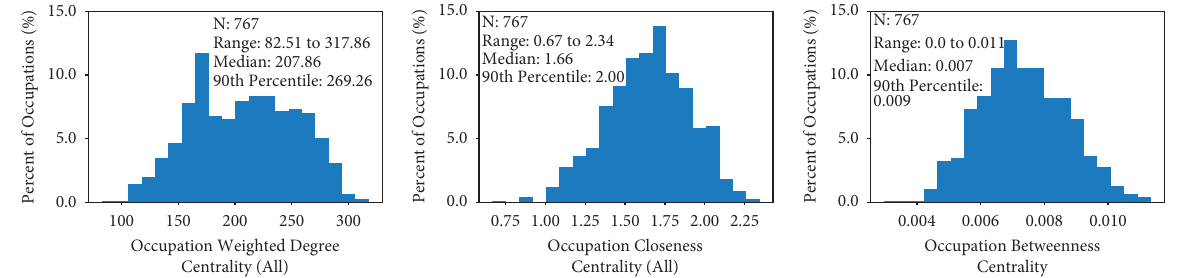
Figure 3: Occupational skill centrality distributions.